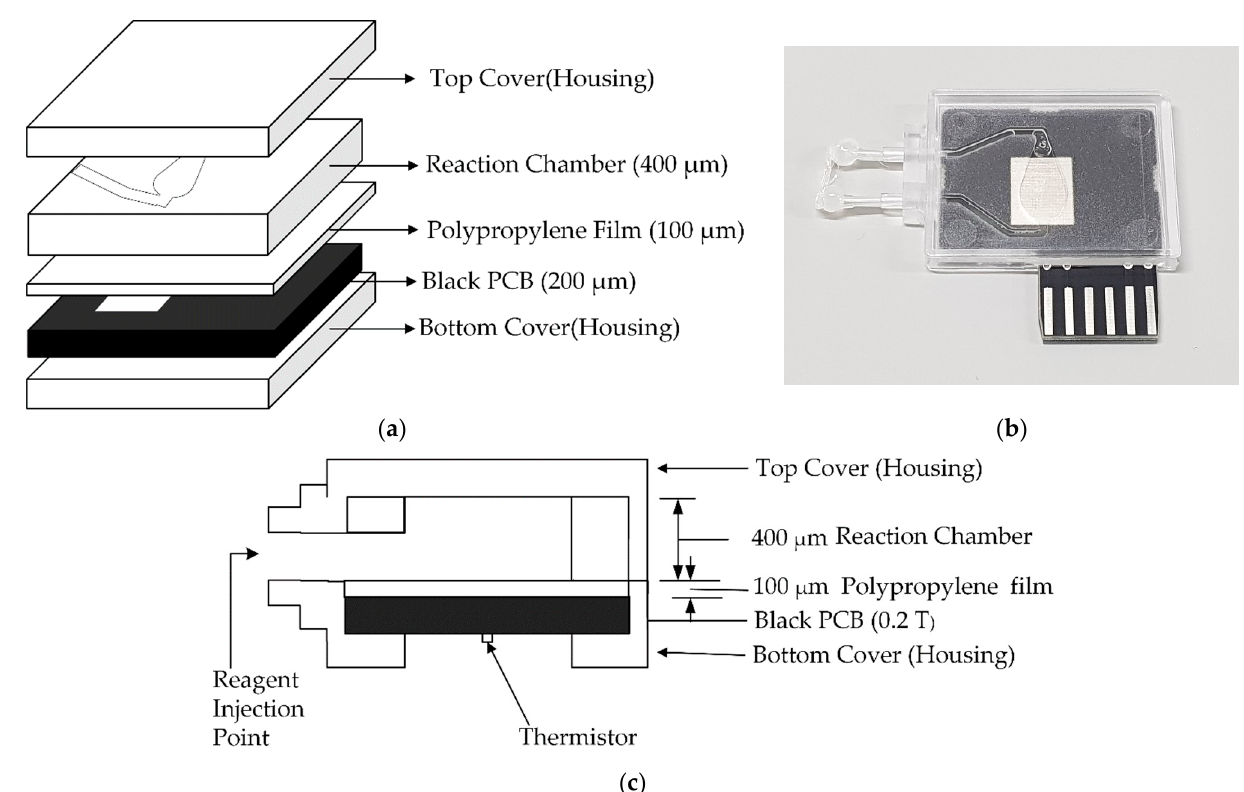
Figure 3. PCR chip structure: ( a ) assembly diagram, ( b ) PCR chip used in the experiment, and ( c ) cross-section.